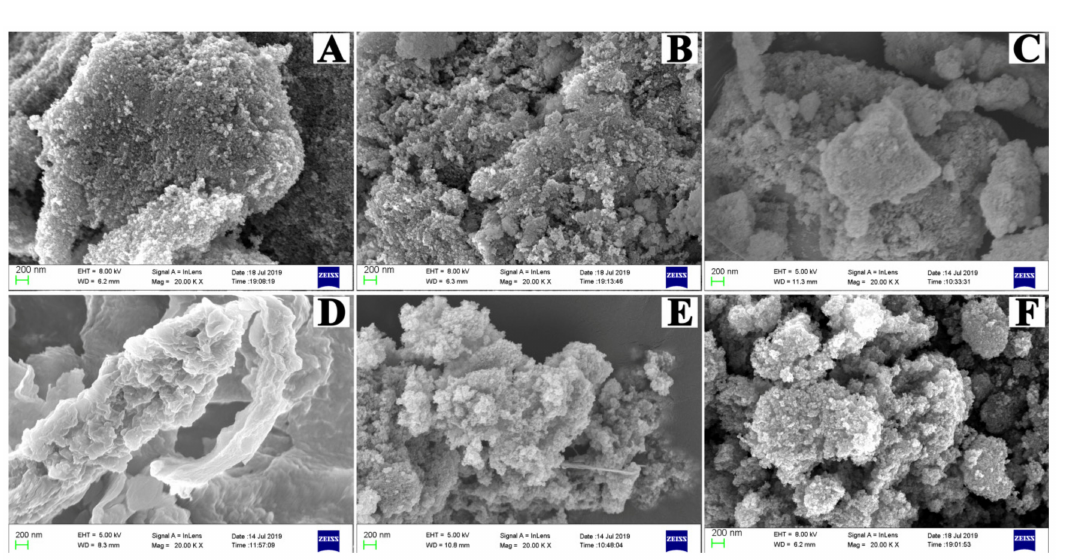
Figure 2. Images of( A ) Fe 3 O 4 MNPs, ( B ) HAP-coated MNPs, ( C ) APTES-HAP-coated MNPs, ( D ) BCL CLEAs, ( E ) BCL mCLEAs, ( F ) Triton-activated BCL mCLEAs.